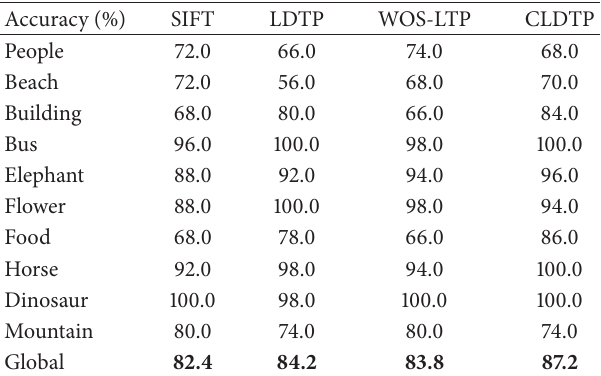
Table 1: Object recognition results on the SIMPLIcity dataset.